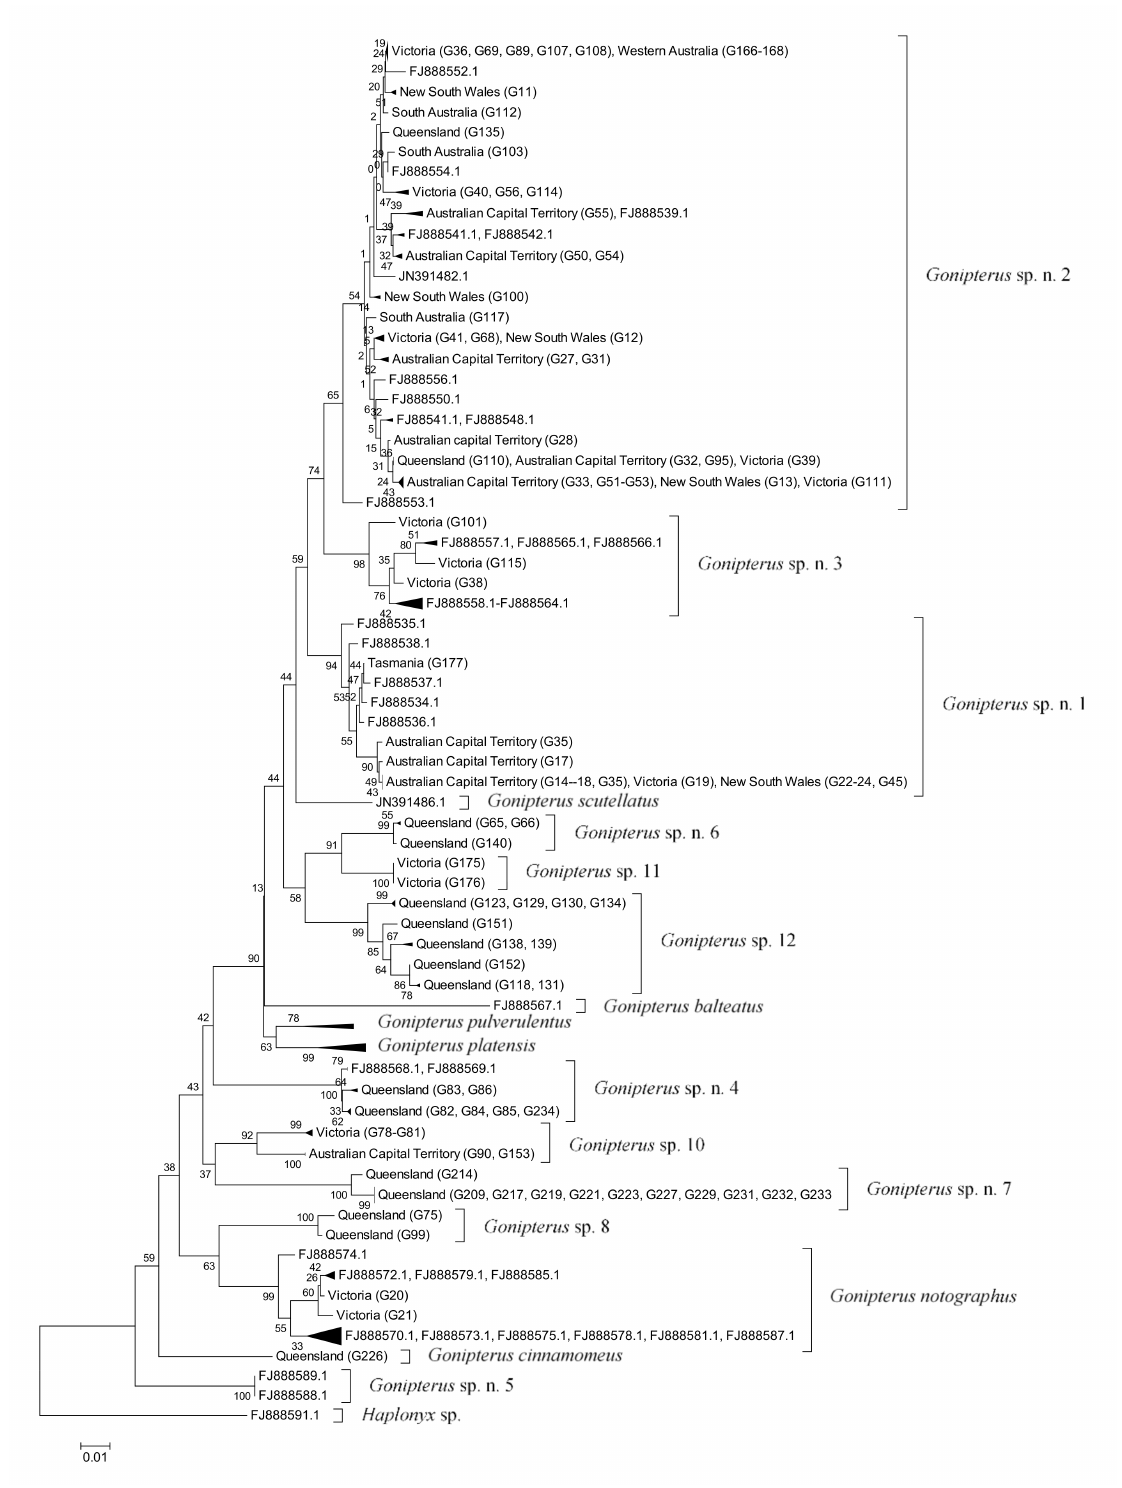
Figure 3. Neighbour joining tree of Cytochrome Oxidase 1 (CO1) gene sequences showing the phylogenetic relationship of G. scutellatus species complex and four closely related species. Twelve clades of Gonipterus can be distinguished. Numbers below nodes indicate the similarity probability (numbers below 30% not shown). Undescribed species of Gonipterus is coded as sp. n. 1–7, unidentified species are coded as Gonipterus sp. 8, 10 and 11. Haplonyx sp. is the outgroup. Geographical location of samples indicated as well as collection number, GenBank accession numbers are used to indicate reference sequences obtained from GenBank. Branches (samples) within a species clade are collapsed if they are from the same Australian state, only GenBank samples or did not show variation within a species